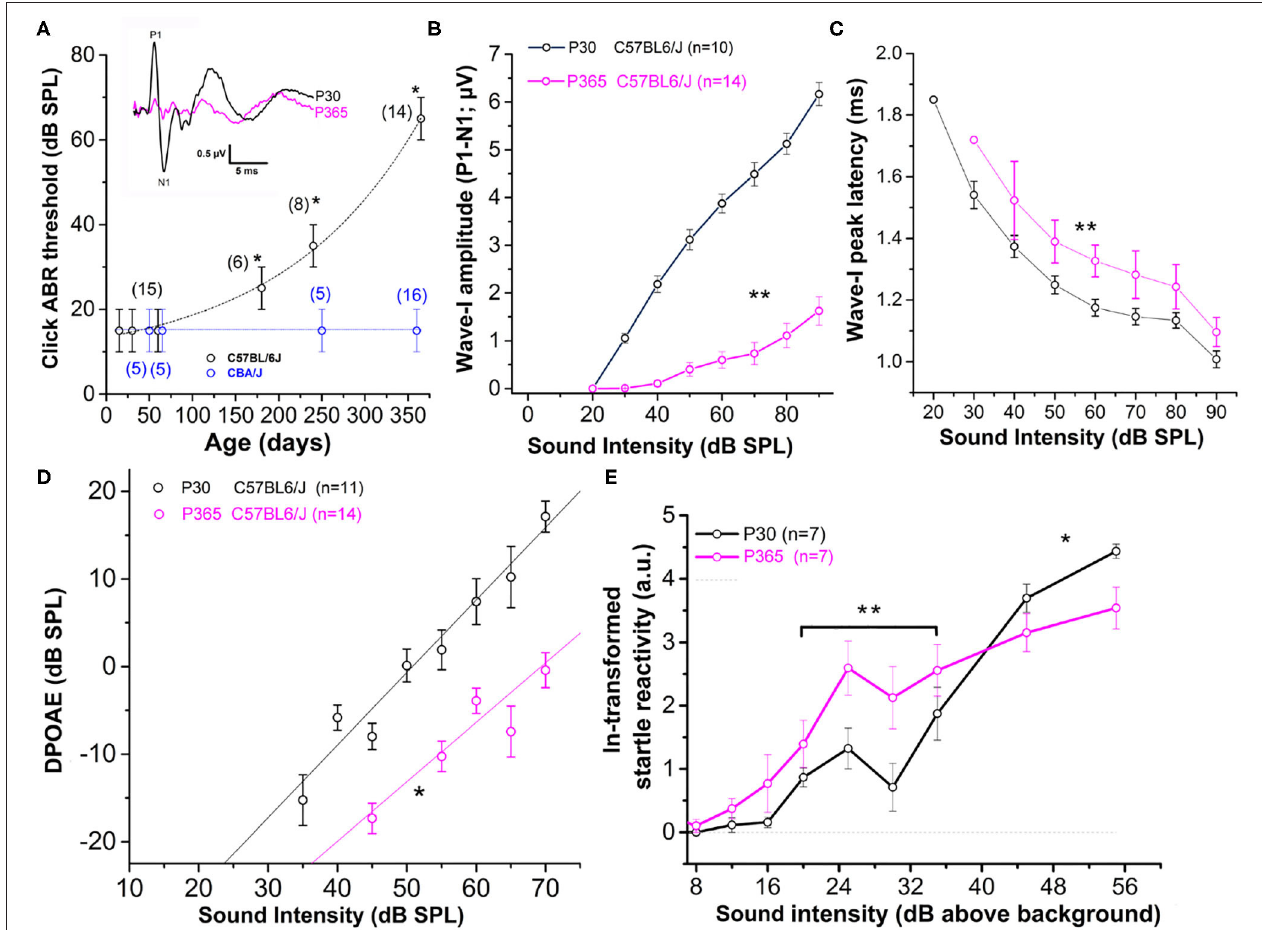
FIGURE 1 | Sensorineural hearing loss with Aging in C57BL/6J mice. (A) Click-ABR thresholds as a function of age in CBA/J mice (blue; n = 5–16) and C57BL/6J mice (black, n = 6–15). For each strain, asterisks indicate significant difference with p < 0.05 as compared to P30 mice (two-way ANOVA). Inset show comparative mean ABR waves at 70 dB SPL in P30 and P365 C57BL/6J mice. (B) Wave-I amplitude (P1–N1) as a function of sound intensity in young P30 (black) and old P365 (pink) C57BL/6J mice. Asterisks indicate significant difference with p < 0.05 (two-way ANOVA; p = 0.001). (C) Latency to reach peak amplitude of wave-I as a function of sound intensity. Significantly different with p = 0.003 between 80 and 50 dB SPL (two-way ANOVA; n is indicated in graph B ). (D) Distortion products otoacoustic emissions (DPOAEs; 2 f 1– f 2 with f 1 = 12.73kHz and f 2 = 15.26kHz) as a function of sound intensity in young P30 (black) and old P360 (pink) C57BL/6J mice. Asterisk indicated significant difference with p < 0.05 (two-way ANOVA, p = 0.01). (E) Startle reactivity to acoustic stimulation. The intensity of startle reaction (in mV) was ln-transformed and obtained through two conditions of white-noise bursts of 20 and 40ms. Note that below 35 dB above background the startle reaction is increased at P360 whereas at 45 and 55 dB above background the startle reaction is decreased compared to P30 mice. Asterisks indicated significant difference with p < 0.05 (two-way ANOVA, p = 0.007 between 20 and 35 dB and p = 0.005 between 45 and 55 dB).